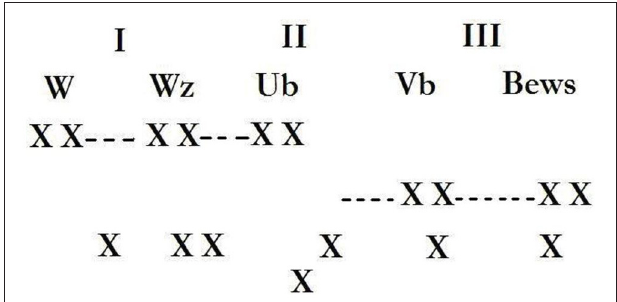
FIGURE 2 | Schema from S. Freud’s letter no 112 (ex-52) to W. Fliess.